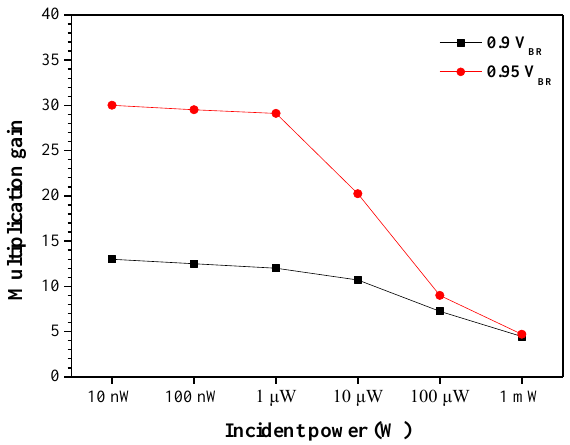
Figure 5. Multiplication gain as a function of incident power from 1 nW to 1 mW under bias voltages of 0.9 V BR and 0.95 V BR .